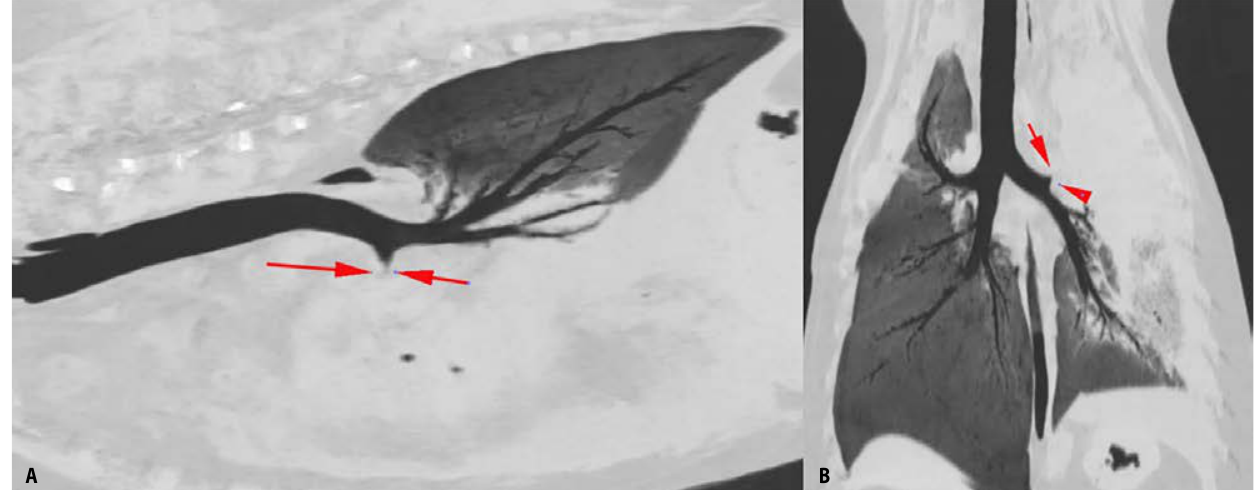
A Figure 1: Sagittal (A) and dorsal (B) multi planner reformat CT images in a lung window showing the cranial lobar bronchus tapering abruptly and becoming indistinct at the level of the hilus. This is consistent with a lung lobe torsion.